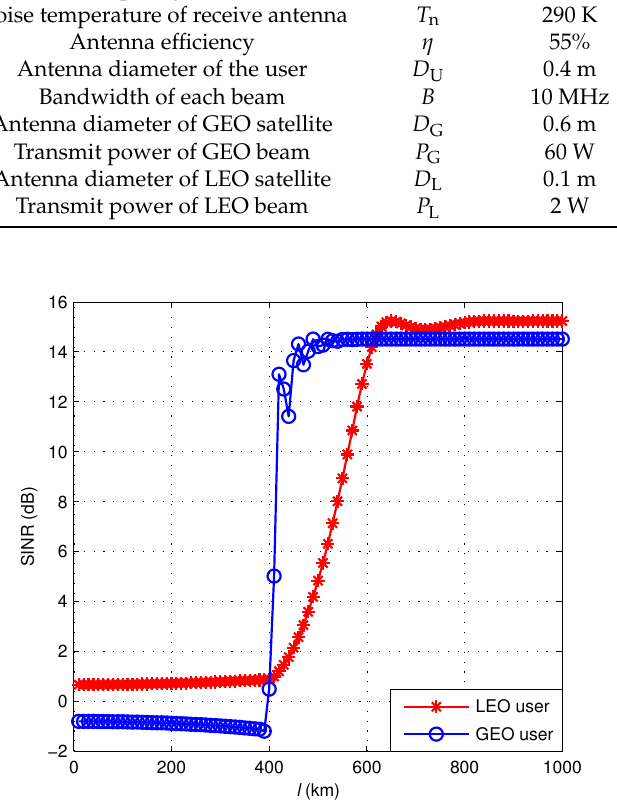
Figure 4. SINR versus l for GEO and LEO